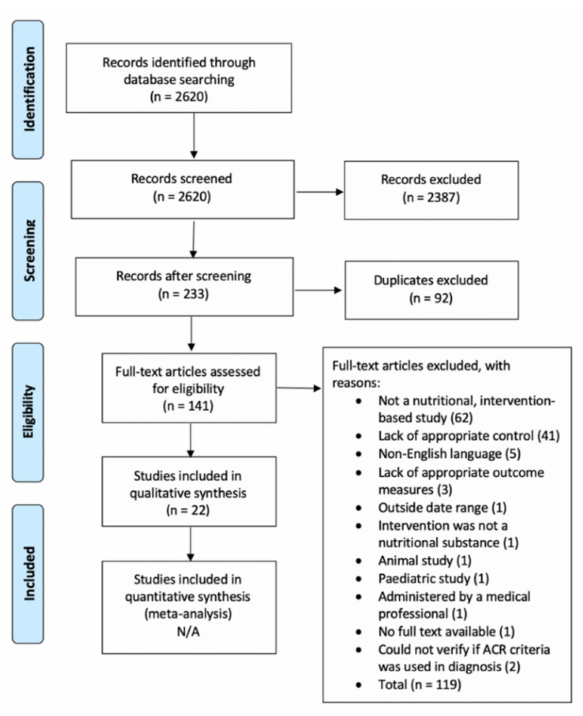
Figure 1. PRISMA 2009 Flow